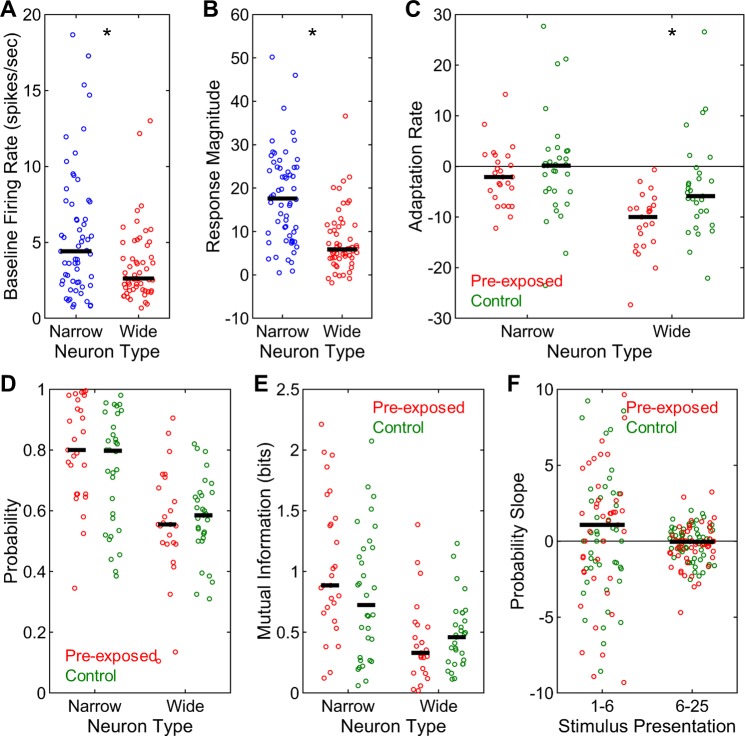
Single-unit response properties and neural decoding in pre-exposed and control conditions.(A) Firing rates during silent baseline conditions were higher for narrow than for wide spike neurons. (B) Stimulus-driven response magnitudes also showed the same effect. (C) Adaptation rates for presentations 1–6 were more negative in the pre-exposed than in the control condition for wide, but not for narrow, spike neurons. (D) Narrow spike neurons had higher correct neural decoding probabilities than did wide spike neurons in both the pre-exposed and the control condition. However, correct neural decoding probabilities were not different between the two conditions either for narrow or for wide spike neurons. (E) Mutual information also showed the same effects. (F) The slopes of correct neural decoding probabilities were higher than zero for presentations 1–6, but not for presentations 6–25. Horizontal black bars indicate medians. Asterisks denote significant differences.